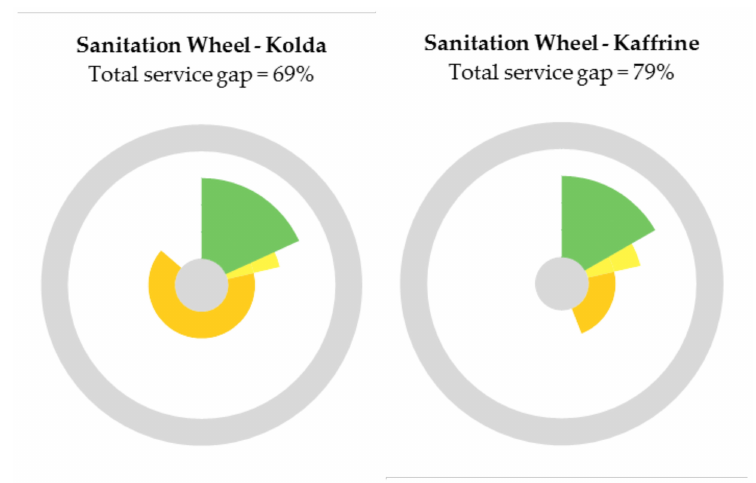
Figure 5. Sanitation wheels for Kolda and Kaffrine, 2015.